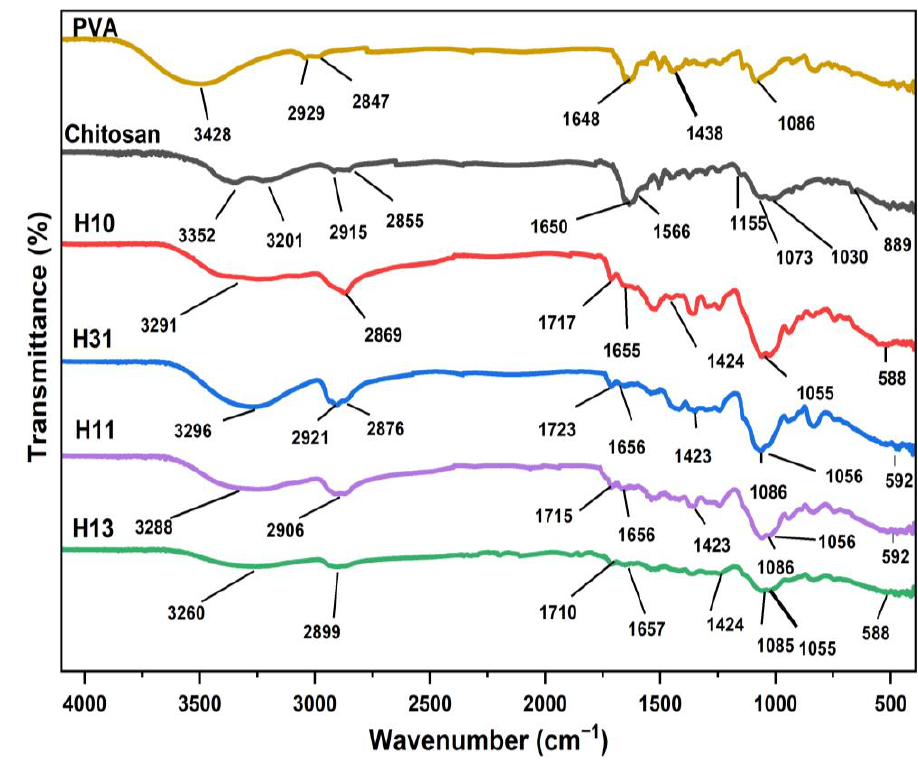
Figure 1. FTIR spectra of chitosan, PVA, H 10 , H 13 , H 11 and H 31 .